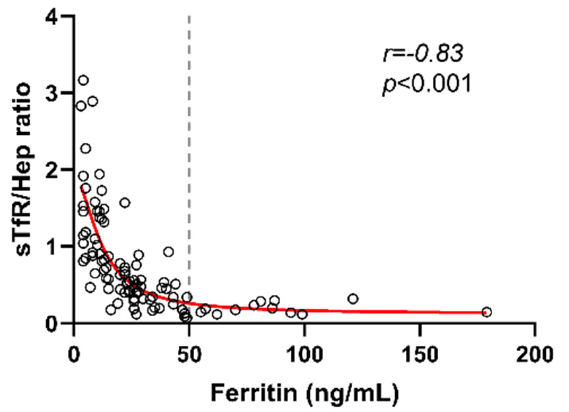
Figure 4. Correlation between sTfR to Hepcidin ratio and ferritin levels in women younger than 50 years old (data available for 96 women). Gray dashed line is the ferritin cut-off of 50 ng/mL. Ab- breviations: sTfR, soluble transferrin receptor; Hep, hepcidin. Spearman’s correlation test was used.